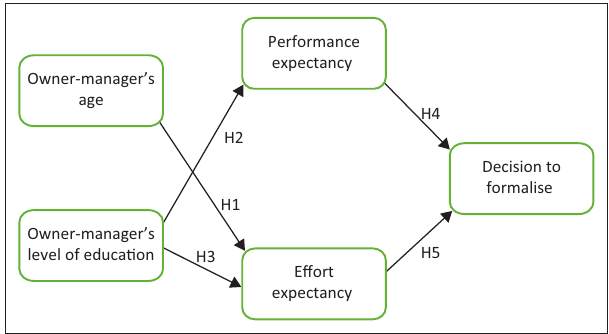
FIGURE 1: The proposed structural